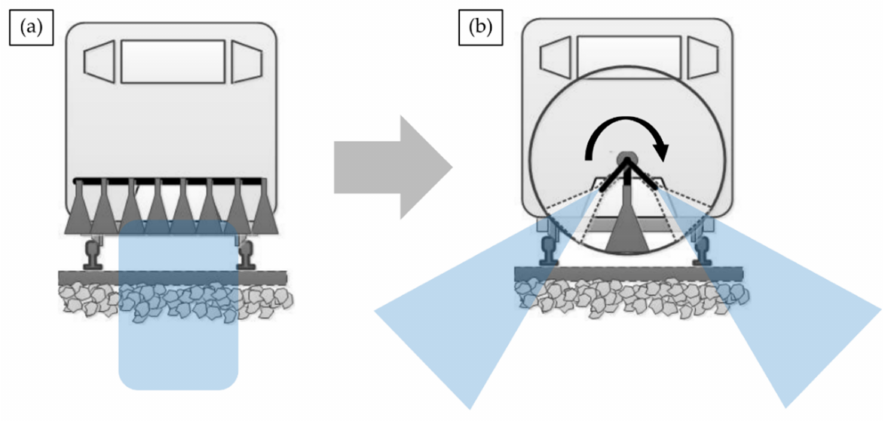
Figure 11. Unlike conventional fixed direction antenna ( a ) which typically only image the railbed; rotating GPR antenna capture 360-degree subsurface profiles including tunnel sidewalls, haunch and crown ( b